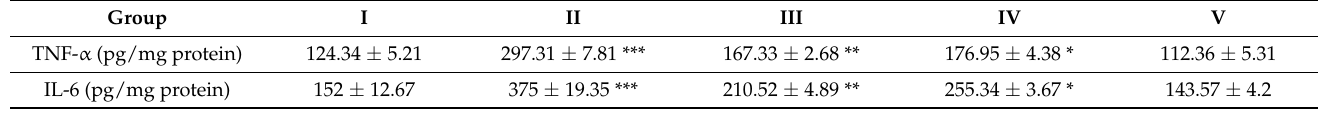
Table 2. TNF- α and IL-6 levels of tumor tissue in the control and groups II, III, IV, and V. Experi- ments were repeated three times and data are presented as mean ± SD. * p < 0.05; ** p < 0.01; and *** p < 0.001 unpaired Student t -test.